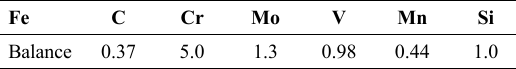
Table 1. Chemical composition of starting powder in wt.-%.